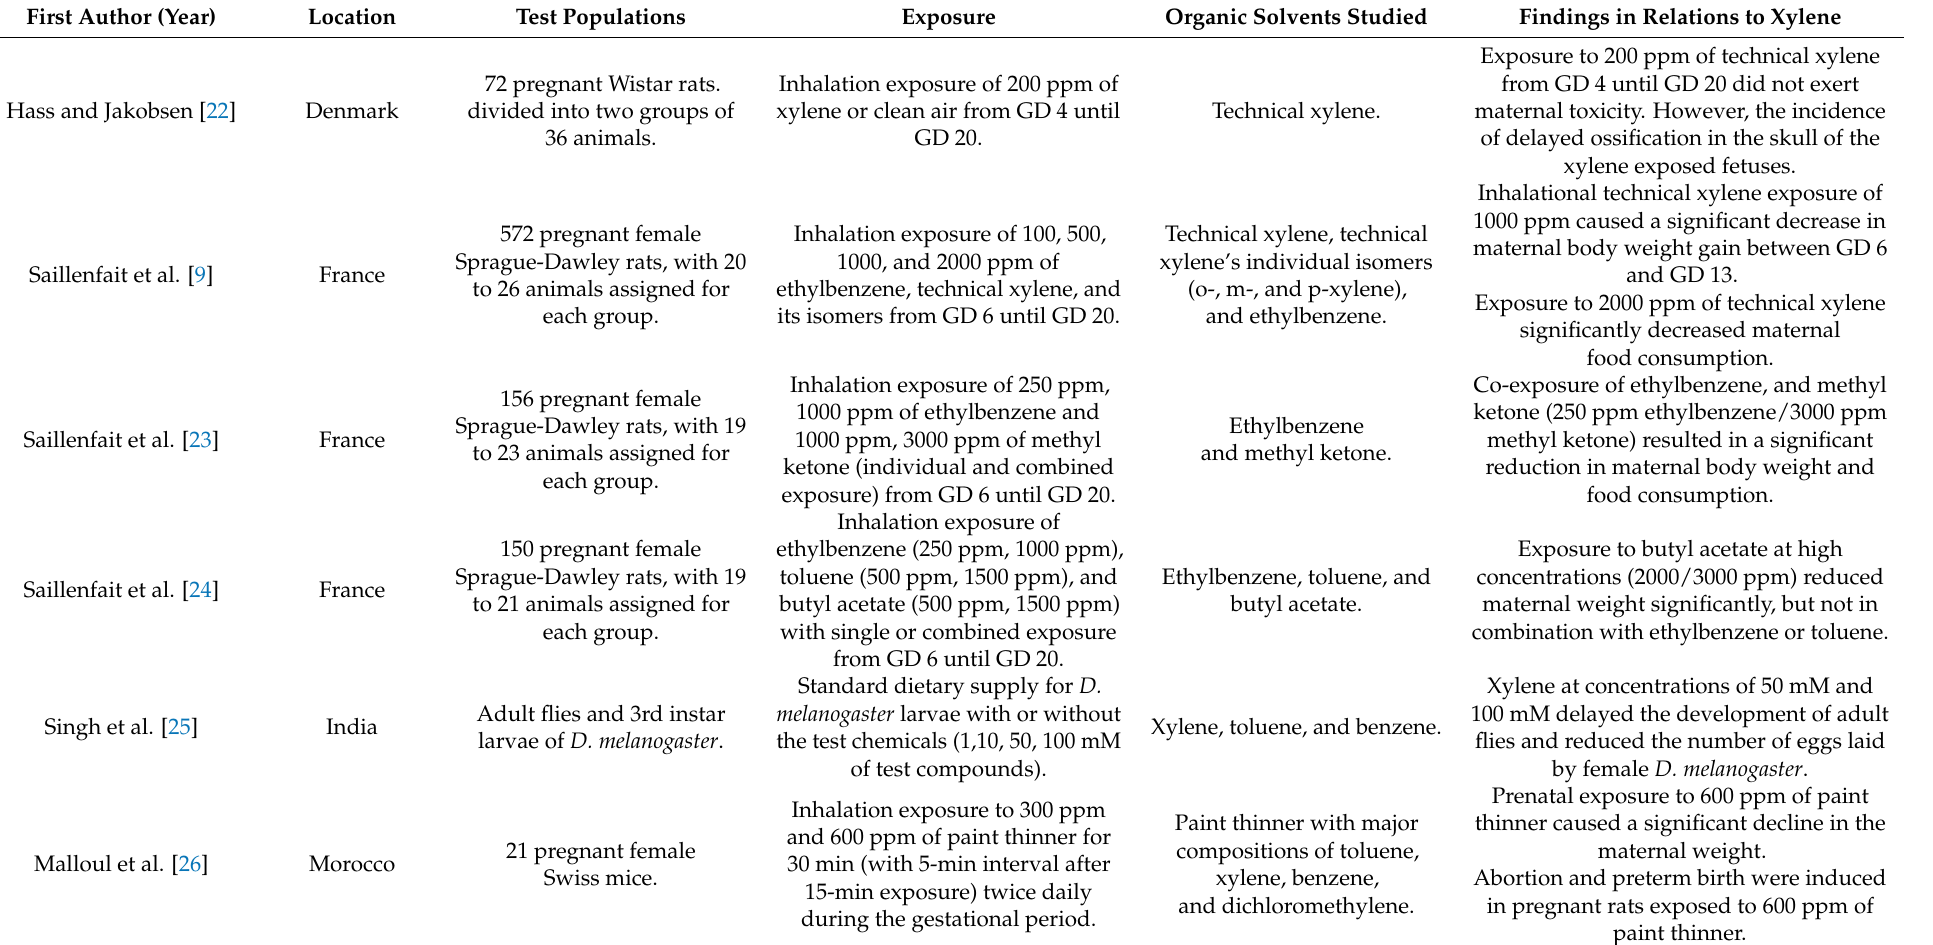
Table 5. In vivo studies on the toxicity of technical xylene to the female reproductive system from 1990 to